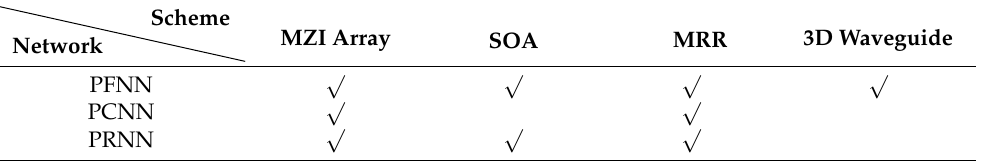
Table 1. The scheme of main neural